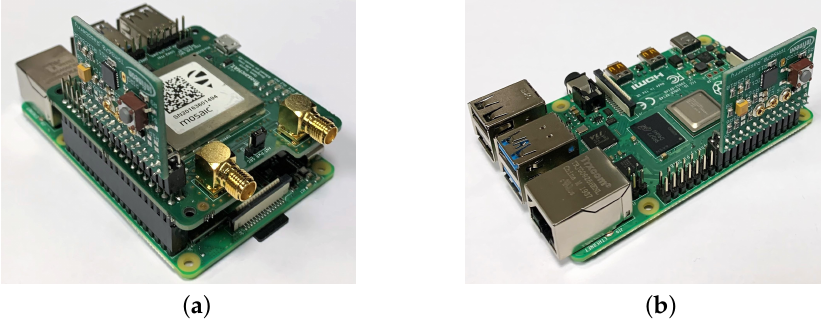
Figure 5. Picture of the Master clock node ( a ) and Slave clock node ( b